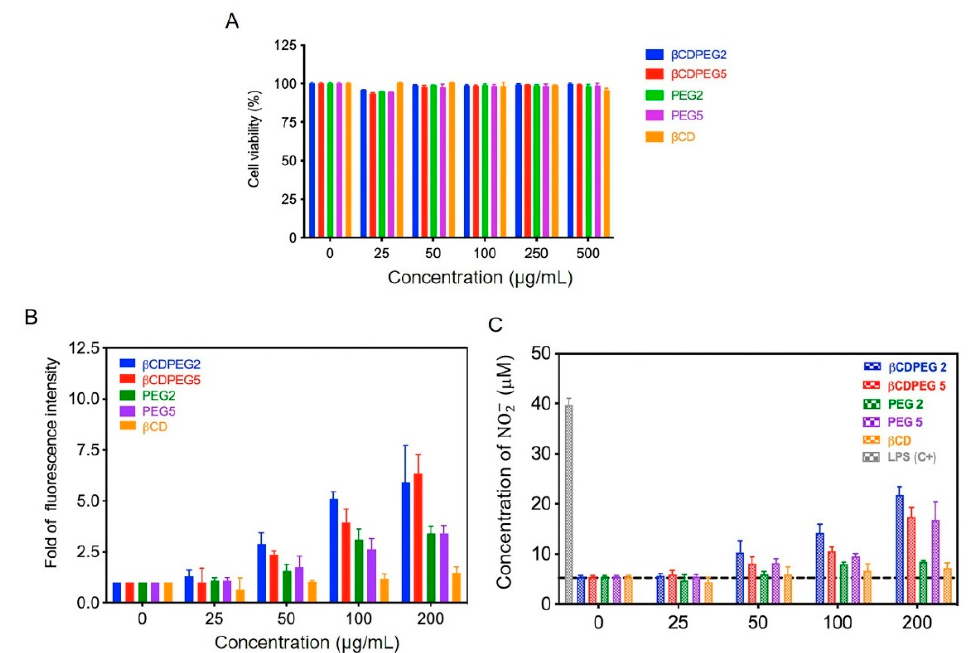
Figure 2. Effect of β CDPEGs, β CD, and PEGs on ( A ) cell viability, ( B ) ROS, and ( C ) NO 2 − production in RAW264.7 macrophages. Dashed line indicates the endogenous concentration of NO 2 − in macrophages grown without treatments. LPS: Lipopolysaccharides used as positive control (C+).